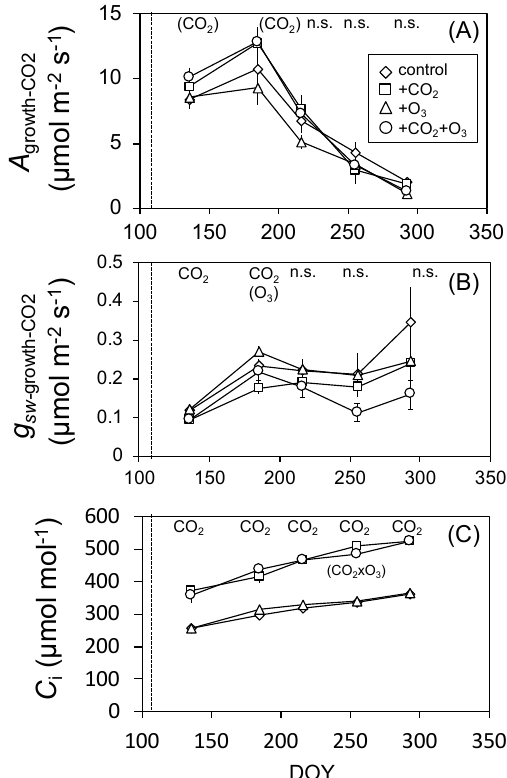
Figure 1. Seasonal changes in the light-saturated net CO 2 assimilation rate ( A growth-CO2 ) ( A ), stomatal conductance ( g sw-growth-CO2 ) ( B ), and intercellular CO 2 concentration ( C i ) ( C ) in the first flush leaves of F. crenata seedlings grown under the CO 2 and O 3 treatment combinations at each ambient CO 2 level (380 and 550 µmol mol − 1 ). Diamond: control, square: elevated CO 2 , triangle: elevated O 3 , circle: the combination of elevated CO 2 and O 3 . Dotted line shows the period of the bud break. The effects ( p < 0.05) of CO 2 treatments, O 3 treatments, and the interaction CO 2 and O 3 on each parameter for each measurement period (five times) are indicated in the panel by CO 2 , O 3 , and CO 2 × O 3 , respectively. The parenthesis indicate difference at p < 0.1, and n.s. indicate nonsignificant ( p > 0.1). Values are means ± SE ( n = 3).